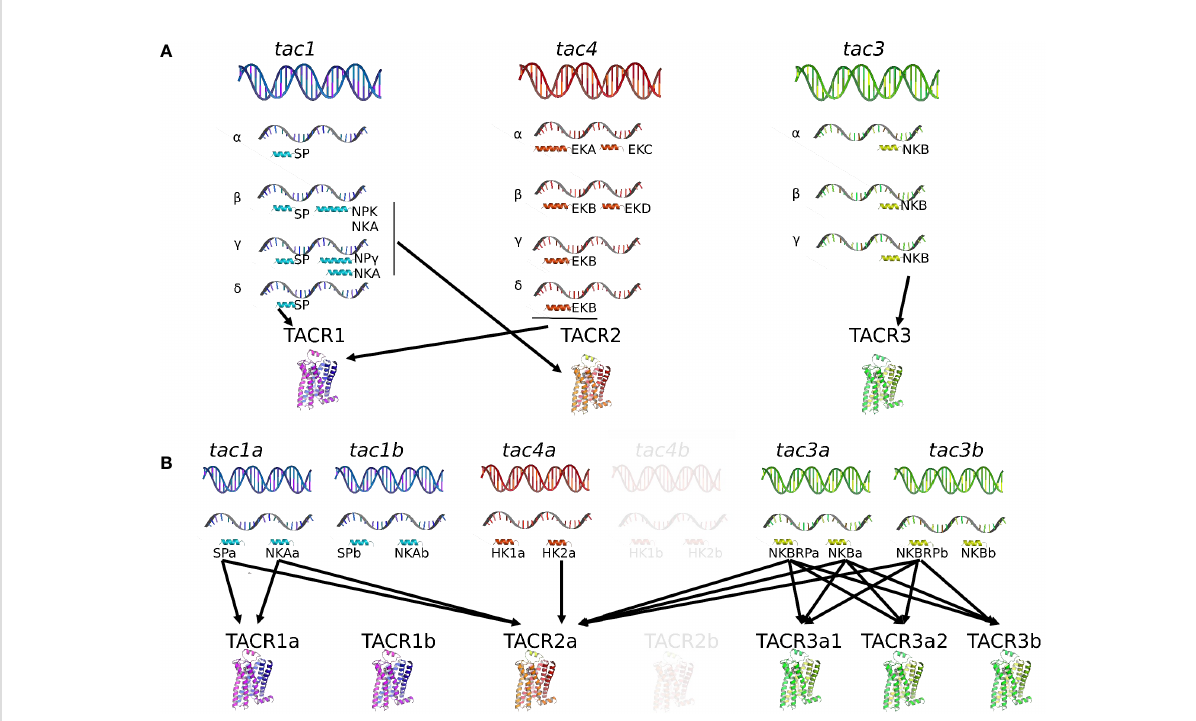
FIGURE 1 Comparison of the tachykinin system in a mammal, the human, and in a teleost, the grass carp. In human (A) , the tachykinin system comprises three tac genes ( tac1 , tac2 , and tac3 ) encoding up to 10 different TAC peptides (SP, NKA, NPK, and NP g for the tac1 gene; HK1, EKA, EKB, EKC, and EKC for the tac4 gene; NKB for the tac3 gene) due to the existence of various spliced variants ( a , b , g , and d for the tac1 and tac4 genes; ( a , b , and g for the tac3 gene). These human TAC peptides bind to three TACR (TACR1, TAC2, and TACR3) with different af fi nities: SP, HK1, EKA, and EKB for TACR1; NKA, NPK, and NP g for TACR2; NKB for TACR3. In teleosts (B) , due to the teleost-speci fi c whole-genome duplication (3R), duplicates for tac1 ( tac1a and tac1b ), tac3 ( tac3a and tac3b ), and tac4 ( tac4a and tac4b ) exist and up to 12 different TAC peptides have been identi fi ed up to now. Up to six TACR have been yet characterized: two TACR1 (TACR1a and TACR1b), one TACR2, and three TACR3 (TACR3a1, TACR3a2, and TACR3b). One of the 3R-duplicated tacr2 paralogs ( tacr2b ) was lost in the teleost lineage but conserved in the